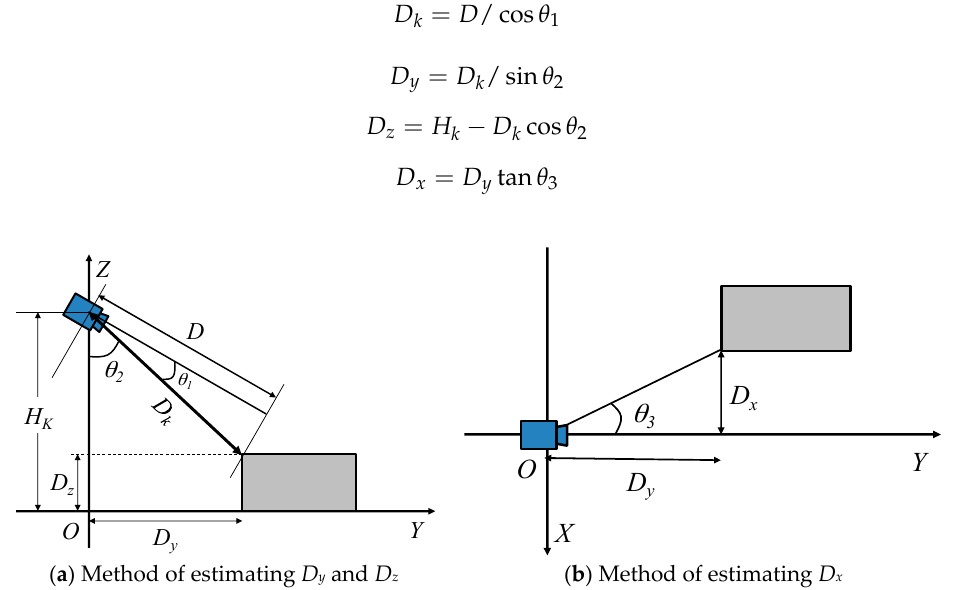
Figure 4. Method of estimating the relative position from the electric wheelchair to the hazardous object.